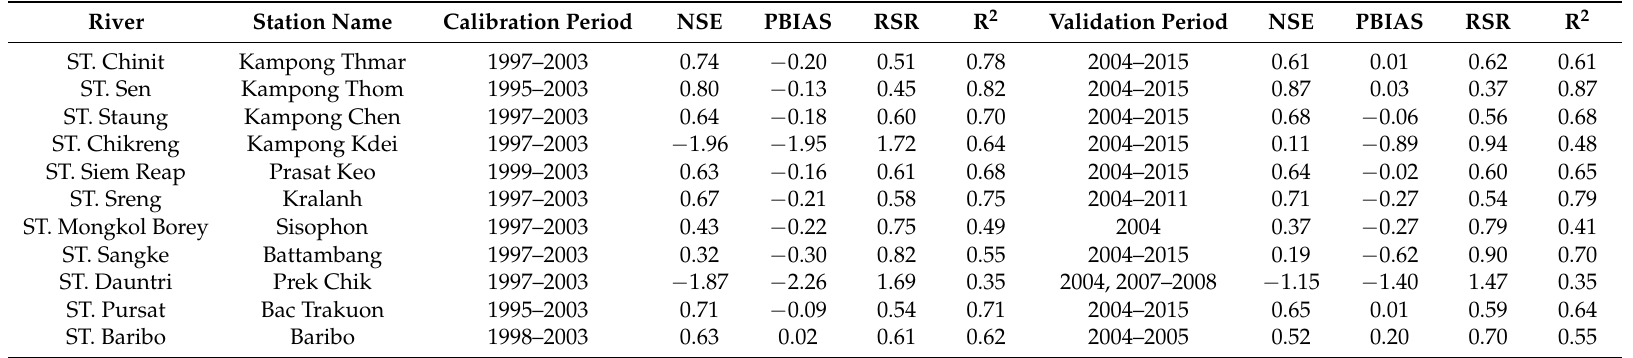
Table 4. Calibration and validation performance (NSE, PBIAS, RSR, and R 2 ) for monthly time step simulation at all 11 rivers in Tonle Sap Lake